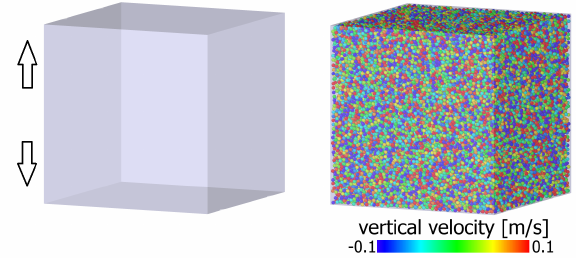
Figure 1. Numerical simulation setup. Left: box used for the simulations with the arrows indicating the vibration direction. Right: Box filled to a packing fraction of 0.35. Particles are colored by their initial vertical velocity distribution.